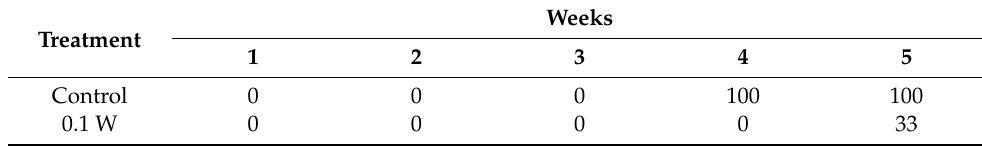
Table 1. Weekly percentage flowering of red perilla (Experiment 1, n = 6). The weekly percentage flowering was determined by dividing the number of plants that formed flower buds by the number of plants tested. Perilla plants were irradiated for 6 h from 23:00 to 05:00 h in a UV-B light treatment regimen. UV-B radiation intensity at the top of the plant canopy was set to 0.1 W m −2 .